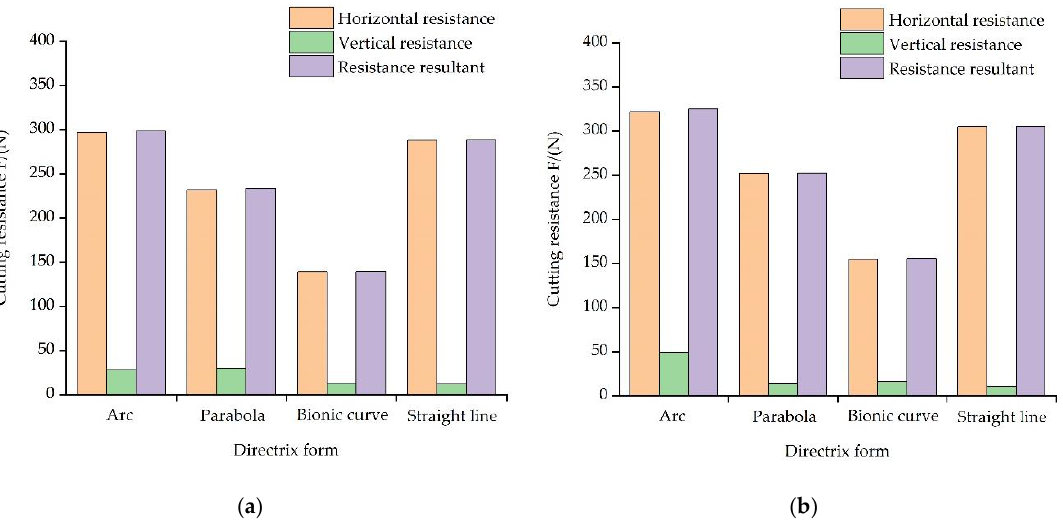
Figure 12. Cutting resistance of four kinds of bulldozing plates. ( a ) Simulation test. ( b ) Actual